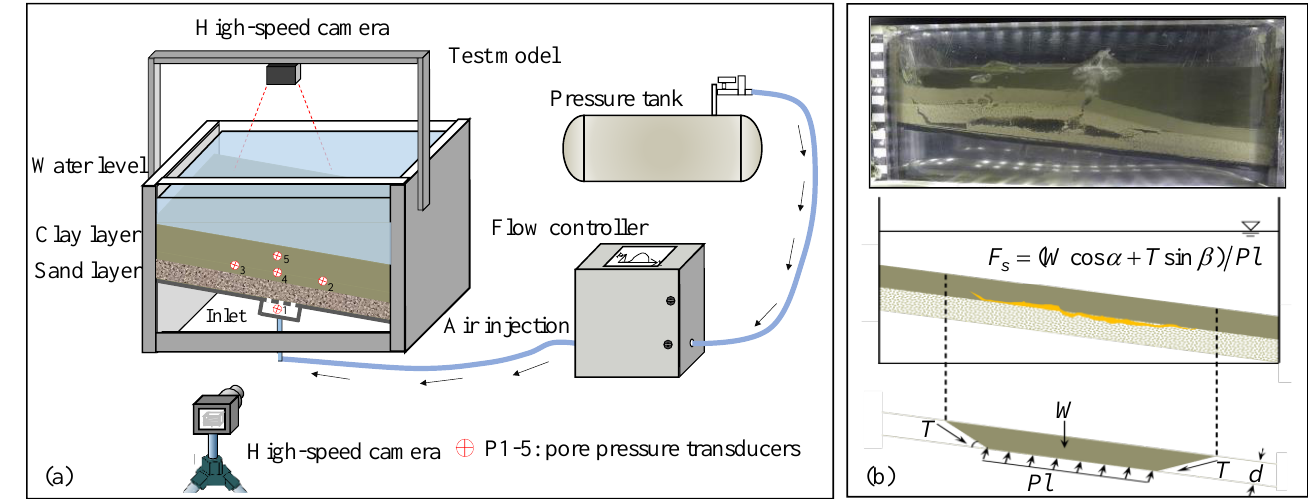
Figure 5. Investigation of submarine landslide induced by hydrate dissociation. ( a ) Schematic diagram of the experimental device; ( b ) Mode of submarine landslide induced by hydrate dissociation. Modified from [45].